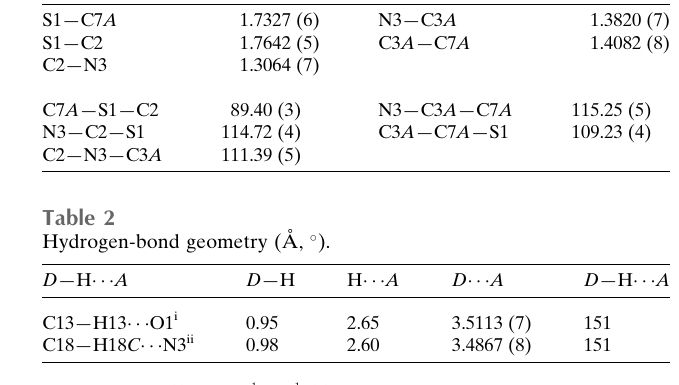
Table 1. Both ring systems are effectively planar (r.m.s. values of 0.01 A˚ for the benzothiazole and 0.004 A˚ for the phenyl ring, respectively), with an interplanar angle of 5.38 (2) (cid:2) . The approximate coplanarity leads to the short intramolecular